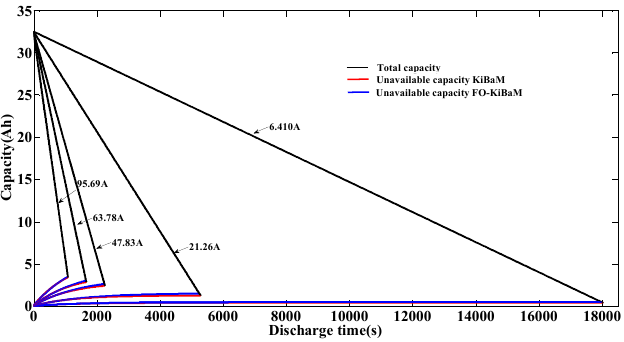
Figure 10. Battery capacity variance at different C-rates.